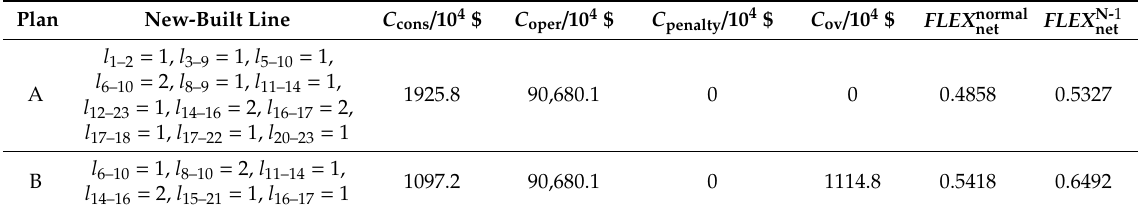
Table 2. Comparison of planning scheme results under typical scenarios.